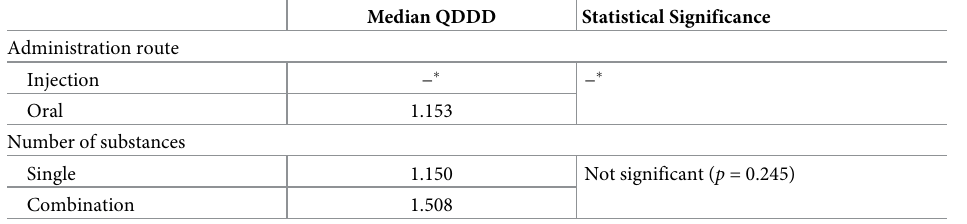
Median QDDD calculated quotient of Japanese daily doses and the corresponding values of the European Medicines Agency � Median QDDD value was not available and statistical evaluation was not possible because there was no antimicrobial agent for injection for which DDDvet and DDDjp values were available